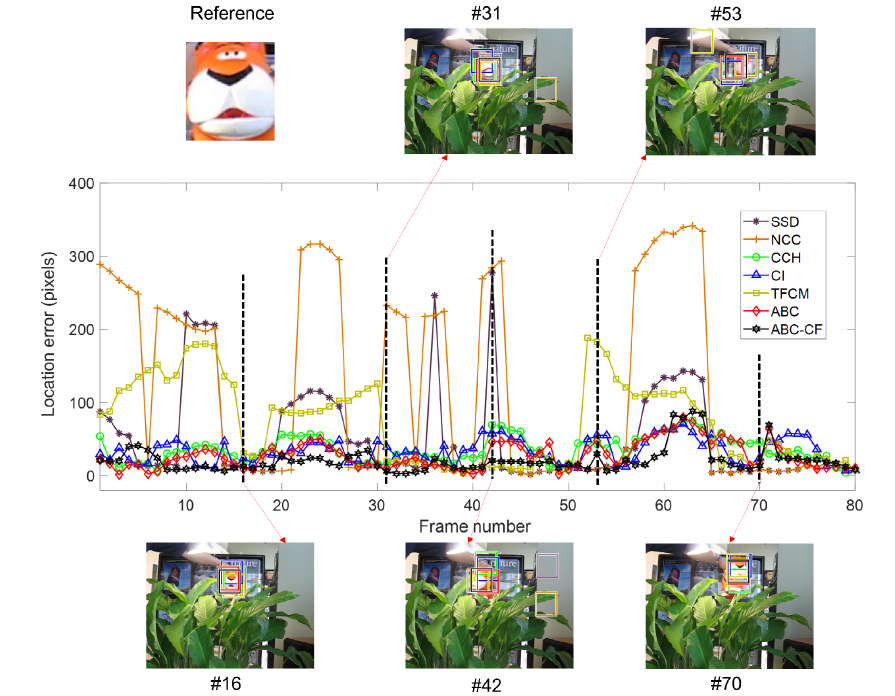
Figure 12. Comparison of template- and color-histogram-based methods.